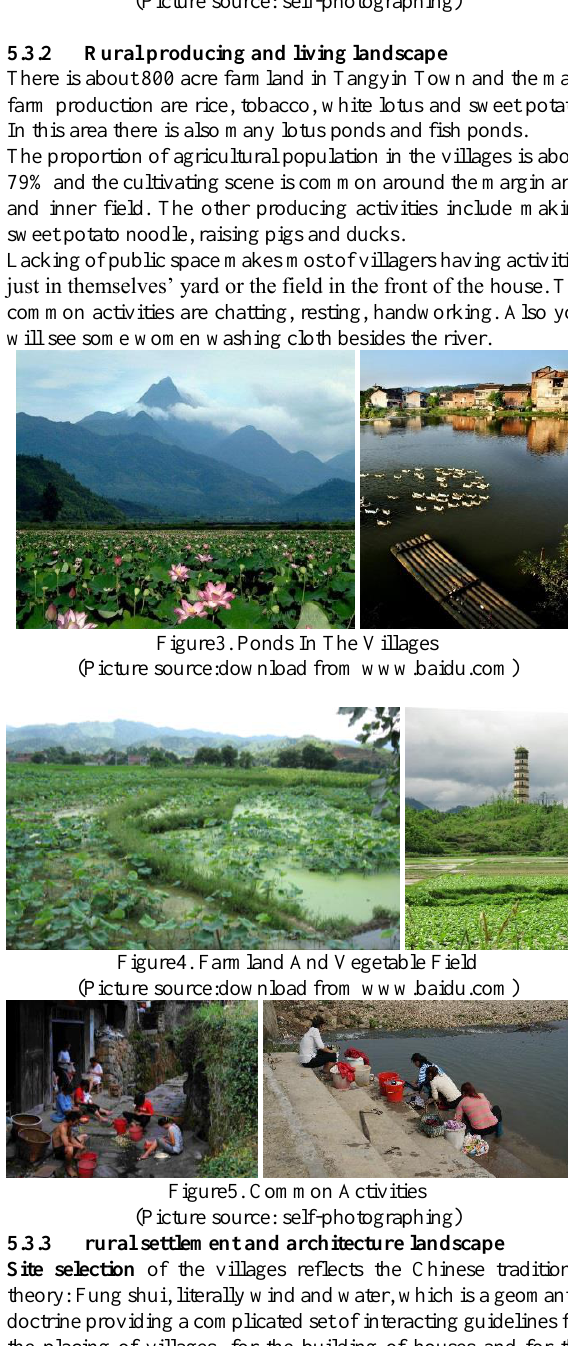
Figure2. Yishui River (Picture source: self-photographing)